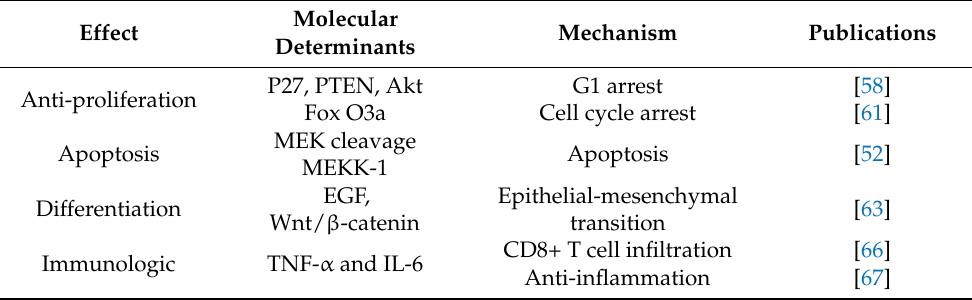
Table 1. Potential anti-tumorigenic mechanisms of vitamin